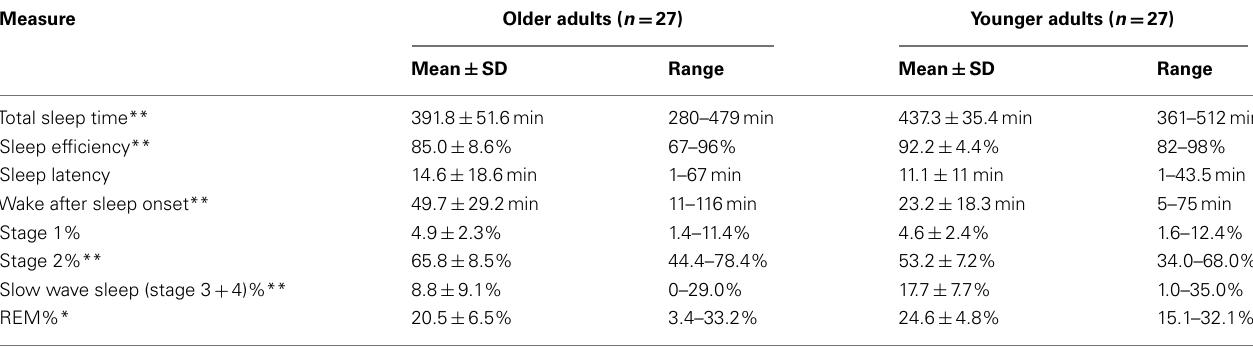
Table 3 | PSG-measured sleep from night prior to fMRI